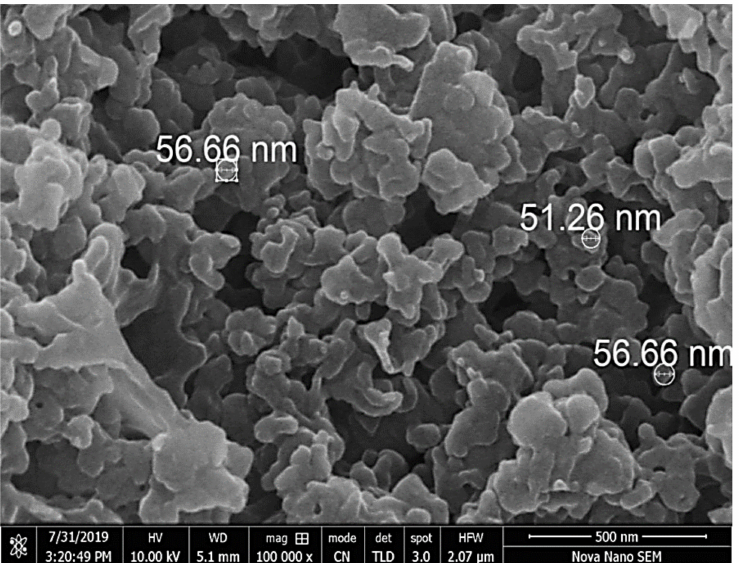
Figure 5. Photomicrograph of SEM analysis of synthesized CuNPs at 100,00x magnification scale in the size range of 500 nm.